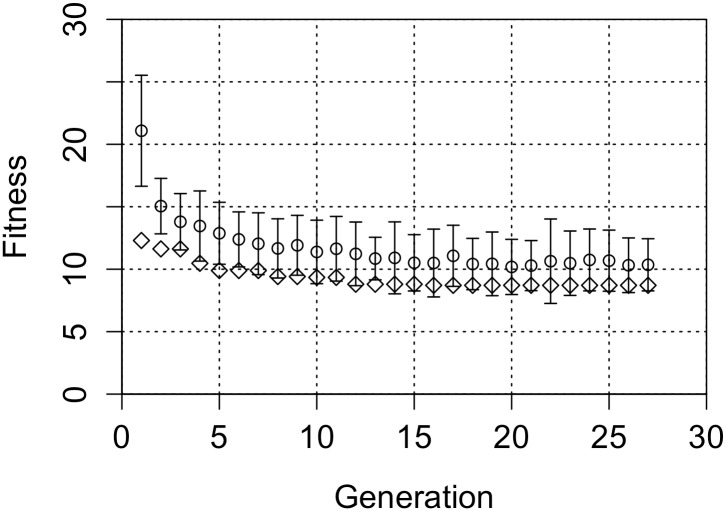
The fitting value as a function of generation of the Genetic Algorithm. The QRP-parameters are kept within a reasonable interval. Circular points show the mean fitness for each generation, with error bars of 1 SE, diamond points show the best fitness per generation.